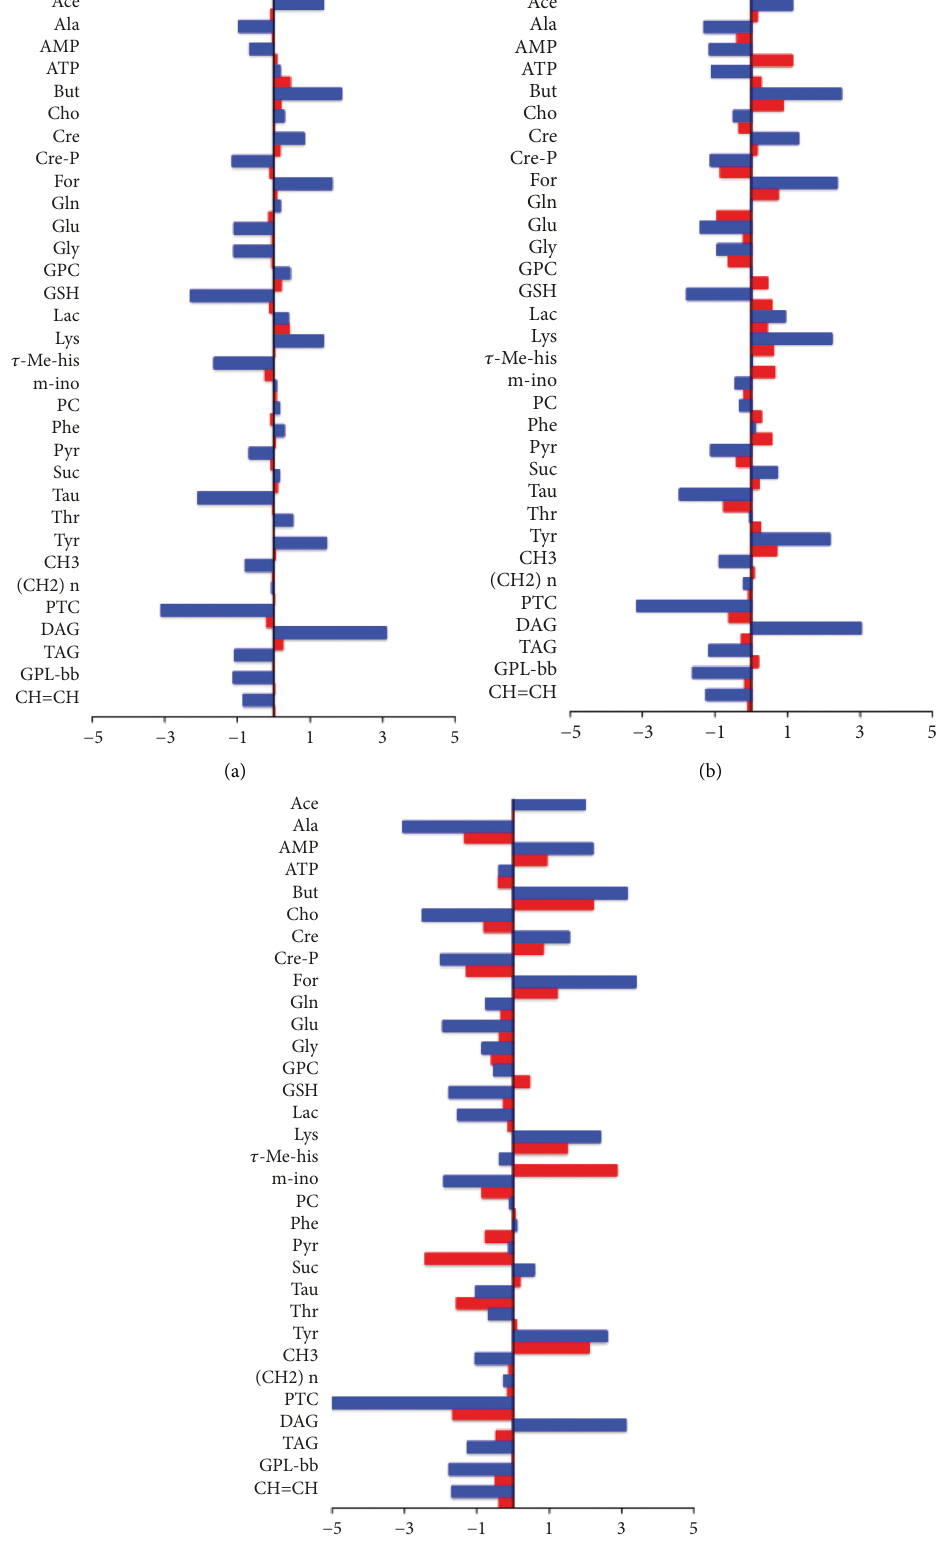
Figure 5: Relevant discriminant metabolites comparison of SH-SY5Y endo-metabolome obtained from different pairwise groups at the different times of treatments: (a) six hours, (b) twelve hours, and (c) twenty-four hours. Blue: Pt-EtOMeSOphen vs. controls; red: cisplatin vs. controls. Metabolites with –Log 2 (FC) negative values have lower concentration compared with controls. Metabolites with –Log 2 (FC) positive values have higher concentration compared with controls. ∗ All the considered FC values have p value < 0.05 except for the cisplatin in panel A in which the FCs have p value >